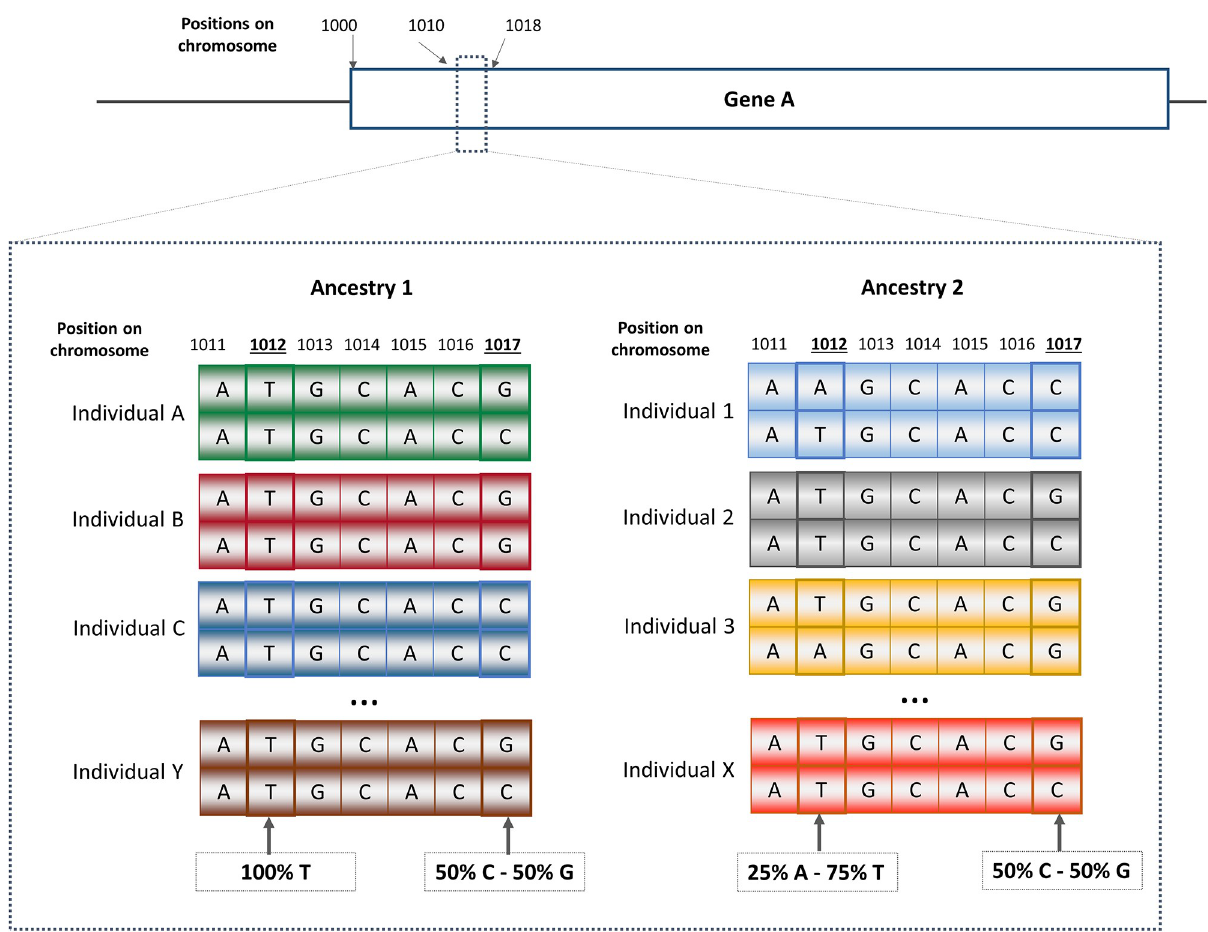
Fig 1. Variation involving 0.1% of the human genome. (A) Proportion of human genome sequence that is similar (blue) and varies (orange) across individuals. (B) A close examination of the DNA sequence (between positions 11 and 17 included) of gene A reveals 2 genetic variants: Variant #1 (position 1012 on chromosome): All participants from Ancestry 1 have a T allele, while participants of ancestry 2 have both T and A allele. This variant could be ethnic specific and could potentially be used as an ancestry marker; Variant #2, (position 1017): the two alleles G and C are observable in both ancestry groups with similar frequencies, hence, this genetic variant is not an ancestry